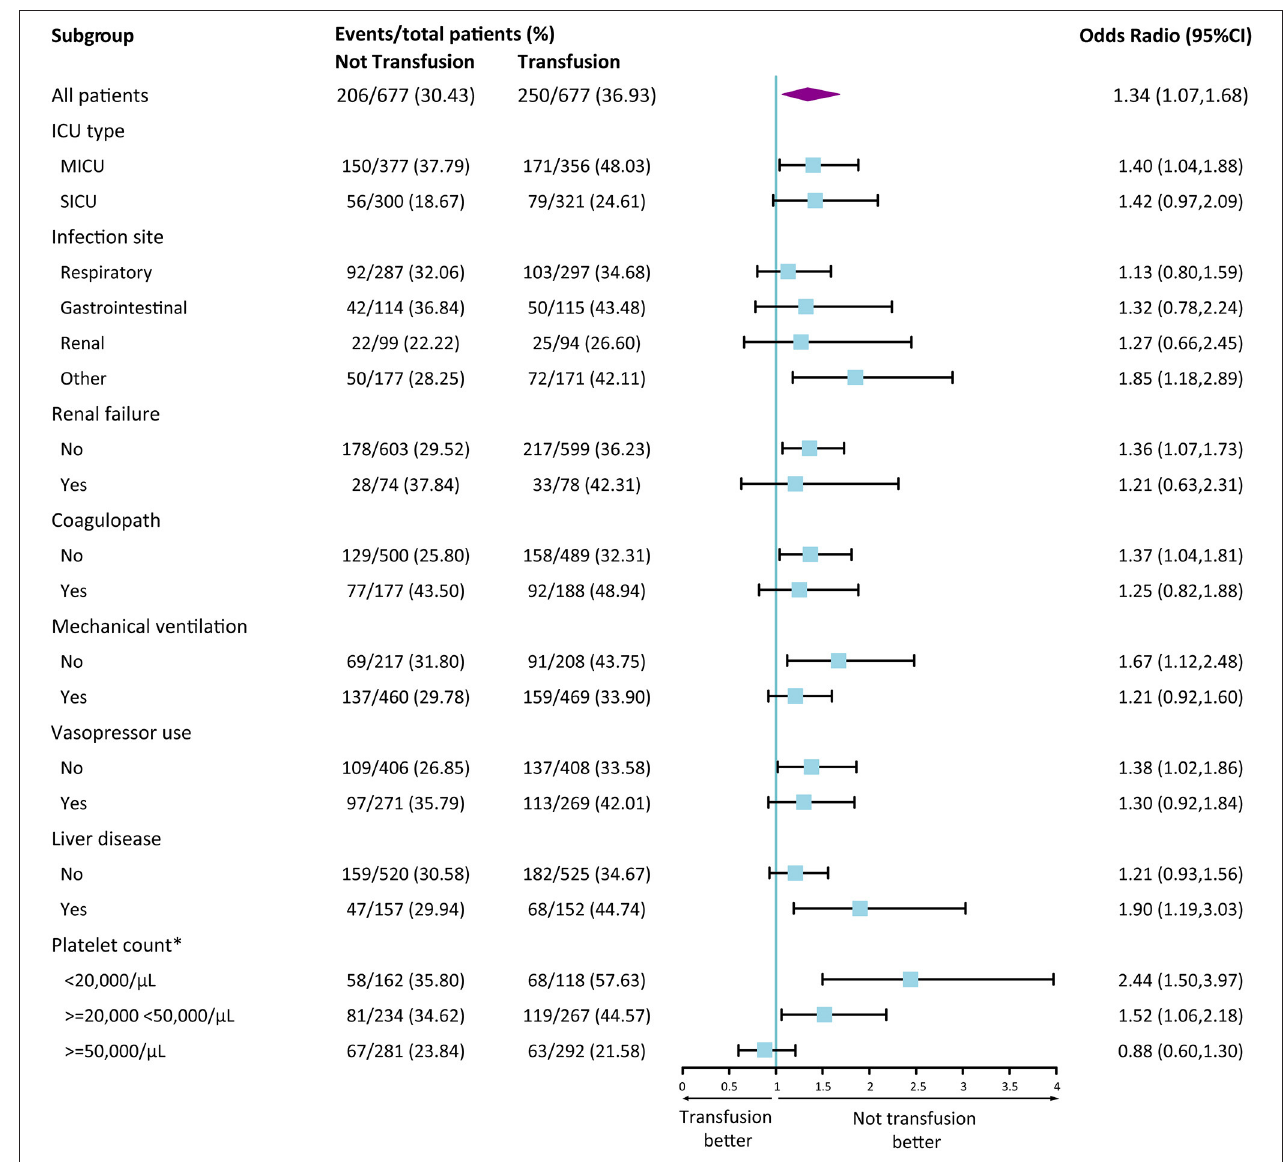
FIGURE 3 | Forest Plot of 28-day mortality according to subgroup in the propensity score matched cohort. Data are shown as the number of 28-day mortality events per total number of patients in that subgroup. Forest plot was used to illustrate the results of multivariate logistic regression analysis according to various subgroups. A Odd Ratio of more than 1.00 indicates a higher risk of death with transfusion group than those with not transfusion. *Interaction analyses were conducted according to platelet group. < 20,000/ µ L vs. 20,000–50,000/ µ L, P for interaction = 0.155; < 20,000/ µ L vs. ≥ 50,000/ µ L, P for interaction < 0.001; 20,000–50,000/ µ L vs. ≥ 50,000/ µ L, P for interaction = 0.055. CI, confidence